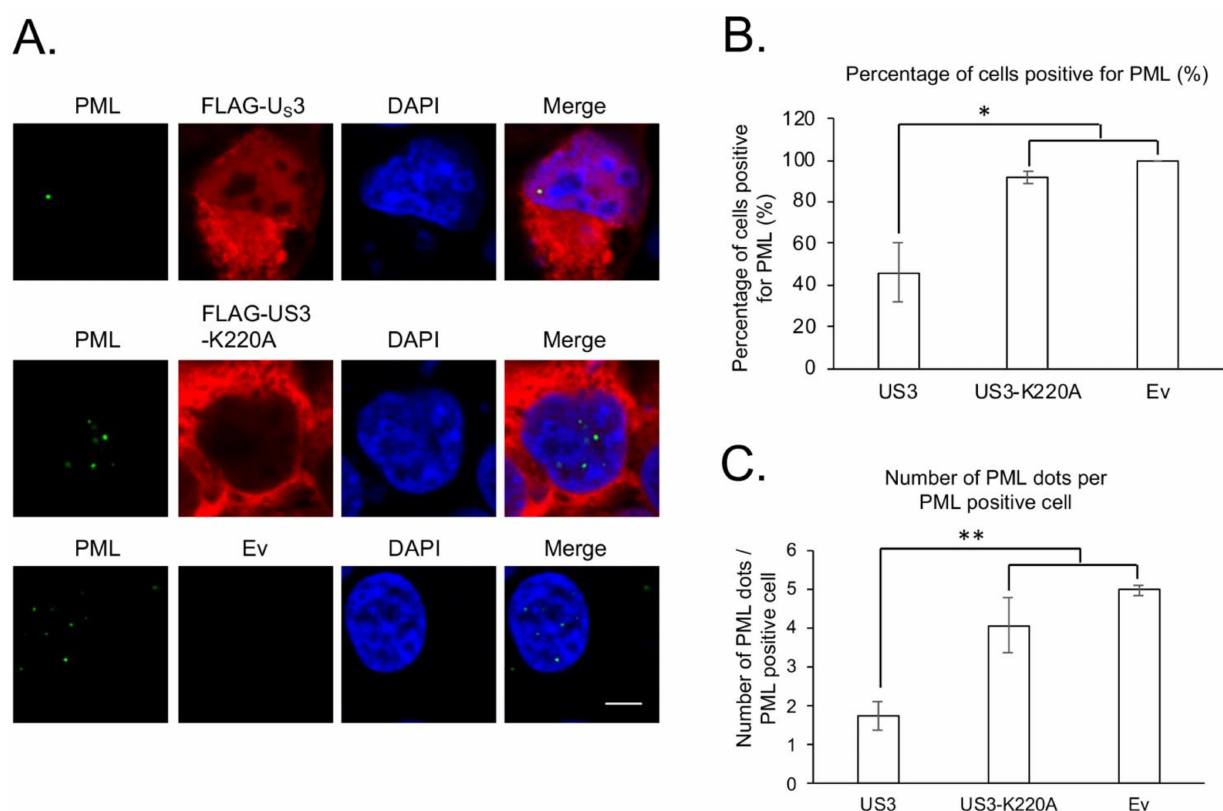
Figure 1. Effect of Marek’s disease virus (MDV) U S 3 on promyelocytic leukemia (PML) protein. ( A ) 293 cells were transfected with pcDNA expressing FLAG-U S 3, FLAG-U S 3-K220A (kinase dead), or empty vector (Ev). Forty-eight hours later, cells were fixed and permeabilized for immunofluorescence assay using primary rabbit anti-FLAG antibody and mouse anti-PML antibody, followed by secondary Texas Red conjugated goat anti-rabbit antibody and Alexa flour 488 conjugated goat anti-mouse antibody. 4 (cid:48) , 6-diamidino-2-phenylindole (DAPI) was used to stain cell nuclei. All images were taken with a confocal microscope at the same magnification, and representative images are presented. Scale bar = 10 µ m. ( B , C ) For each group, the percentage of cells positive for PML ( B ) and the number of PML dots per PML positive cell ( C ) were counted from 50 randomly selected U S 3 or U S 3-K220A transfection positive cells using Image J software. Only cells that were positive for PML were used to calculate the average number of PML dots per cell. Results are presented as average number from two independent transfection experiments; error bars represent standard deviation (SD). Student’s t test was performed between U S 3, or U S 3-K220A and Ev transfected cells, and statistical significance is indicated with an asterisk. *: p < 0.05; **: p <